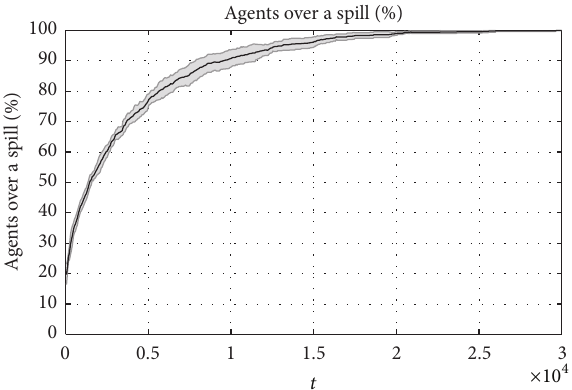
Figure 6: Percentage of agents on an oil slick with respect to time (in seconds) for a complex slick. Ten different experiments have been carried out, showing the average and